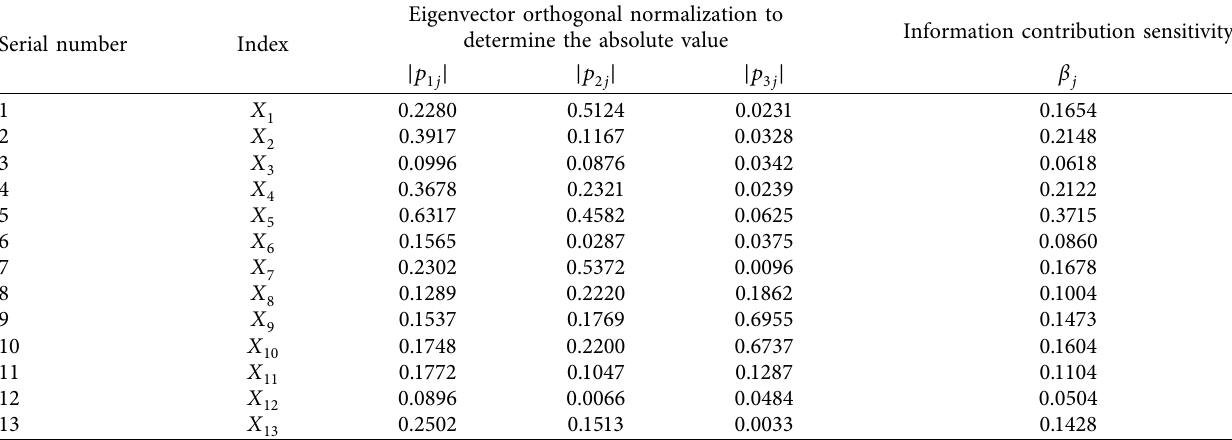
Table 4: The results of orthogonal normalization of the first three principal component eigenvectors to determine the absolute values.